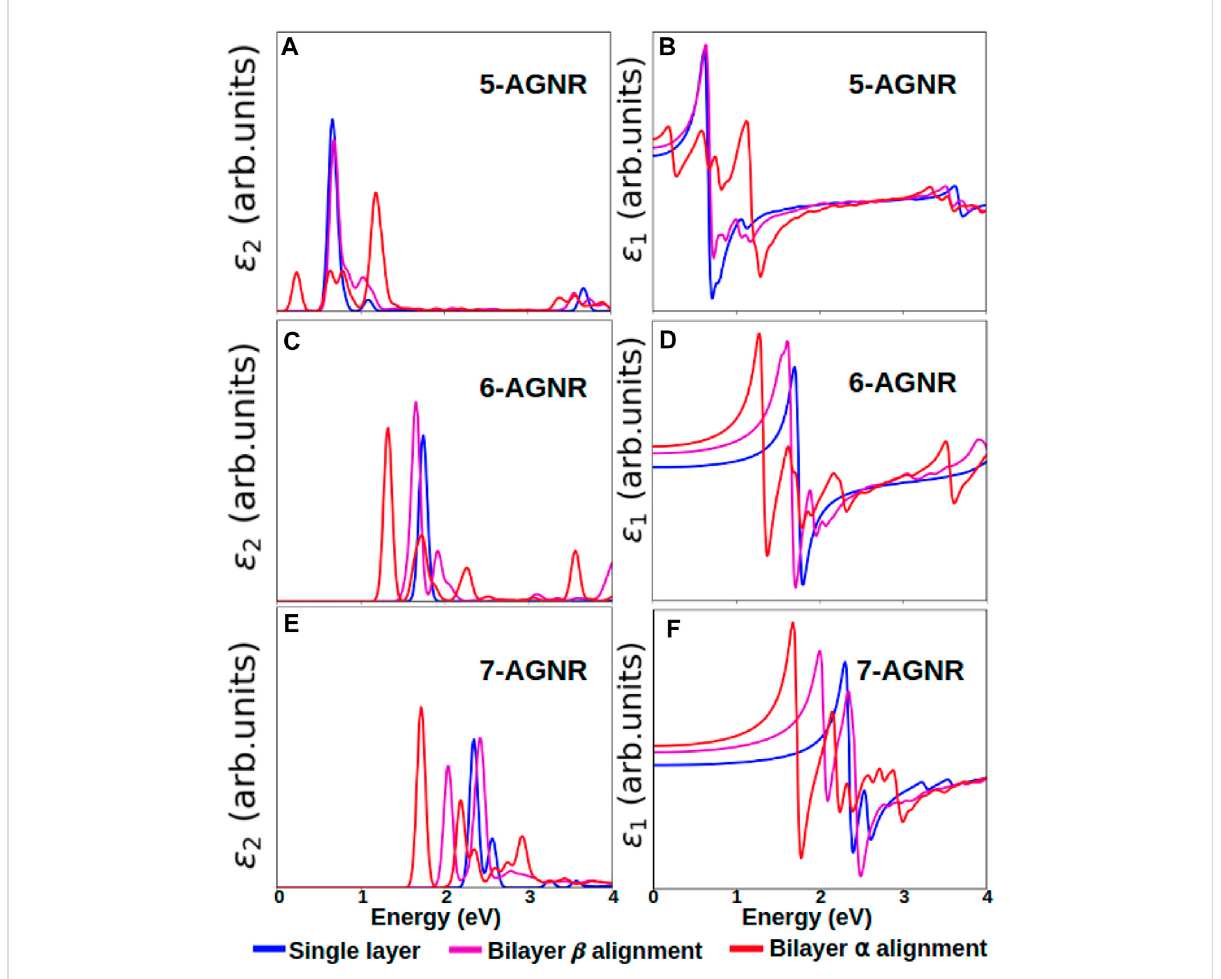
FIGURE 10 Comparison of the imaginary and the real parts of dielectric functions of single layer, bilayer α alignment and bilayer β alignment armchair graphene nanoribbons. Imaginary and realpartofthedielectric functionfor (A,B) 5-AGNR, (C,D) 6-AGNRand (E,F) 7-AGNR.Bluelines denotesingle layer nanoribbons, magenta lines denote bilayer β alignment nanoribbons, and red lines denote bilayer α alignment